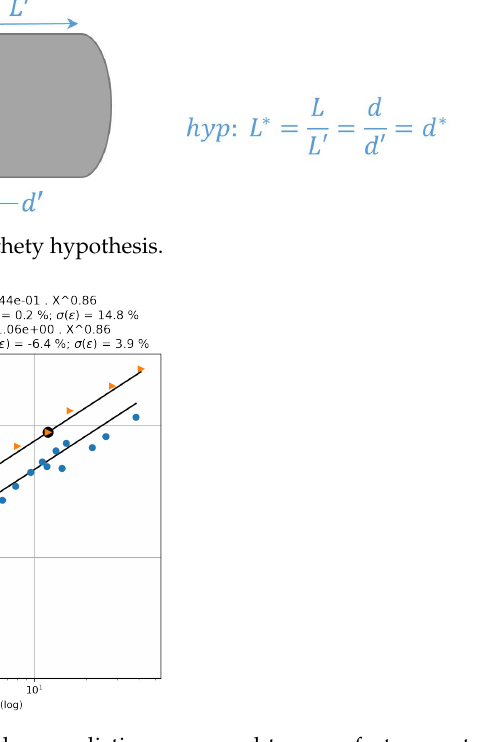
Figure 10. Motor mass: scaling law prediction compared to manufacturer catalogs (Parvex NX, Kollmorgen